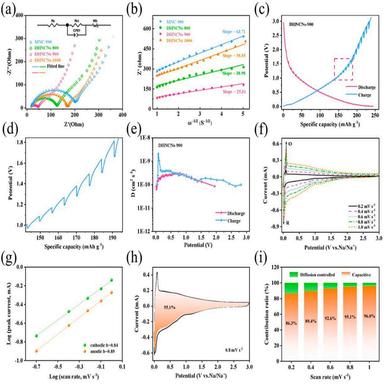
Nyquist plots of the MNC-900 and DHNCNs-T electrodes before cycling (a), the linear relation of ω-1/2 versus Z' of the MNC-900 and DHNCNs-T electrodes (b), GITT profiles (c) with magnified curve of the DHNCNs-900 electrode (d) and corresponding diffusion coefficients of Na+ during the discharge/charge process (e). CV curves of DHNCNs-900 electrode at various scan rates from 0.2 to 1.0 mV s − 1 (f), b-values plotted for the cathodic and anodic of the DHNCNs-900 electrode (g), the capacitive contribution (sha